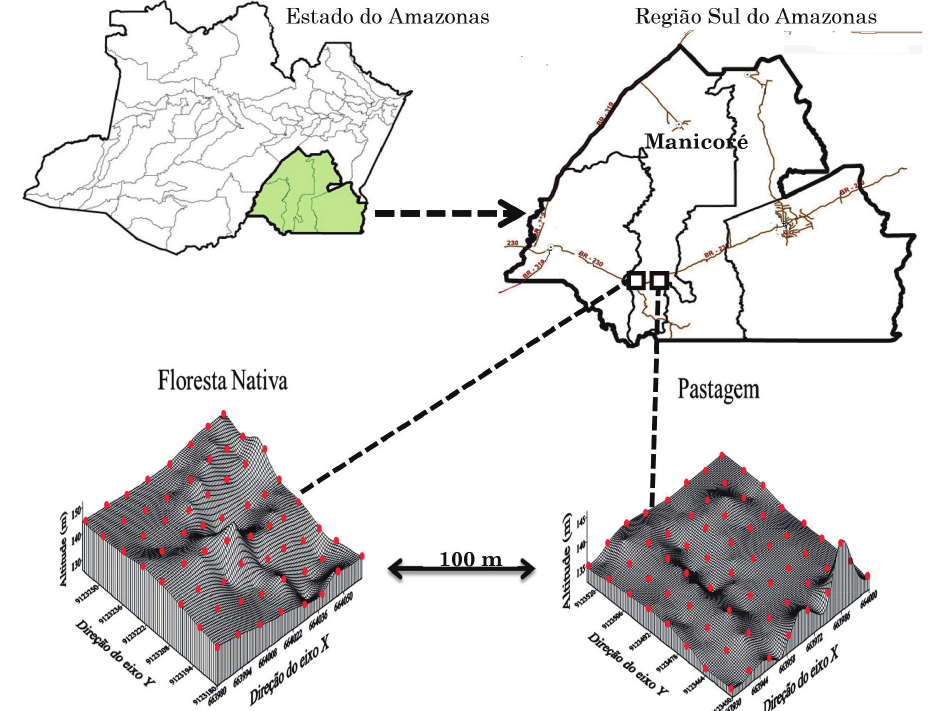
Figura 1. Localização da área de estudo, modelo de elevação digital e pontos de coleta de amostras de